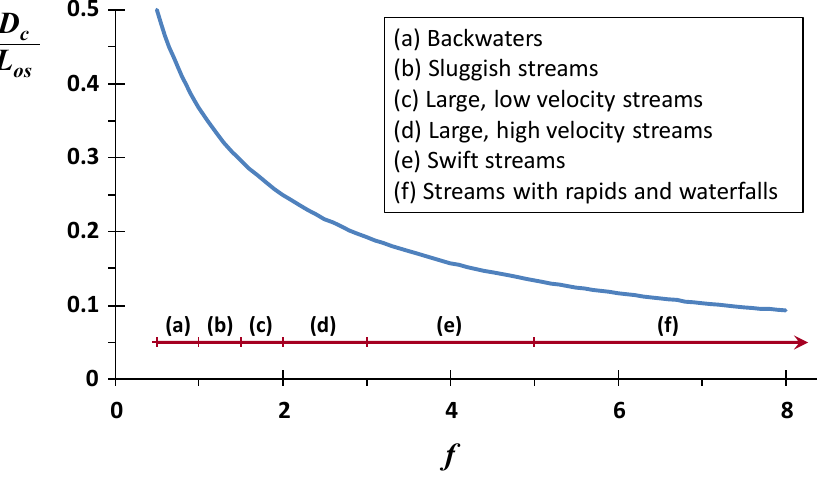
Figure 5. Plot of the ratio of critical deficit to the sustainable mixing-point concentration of carbo- naceous BOD versus the self-purification constant at 20 °C. The “sustainable mixing-point concen- tration” is the level to maintain the downstream critical oxygen concentration at the value where hypoxia begins.